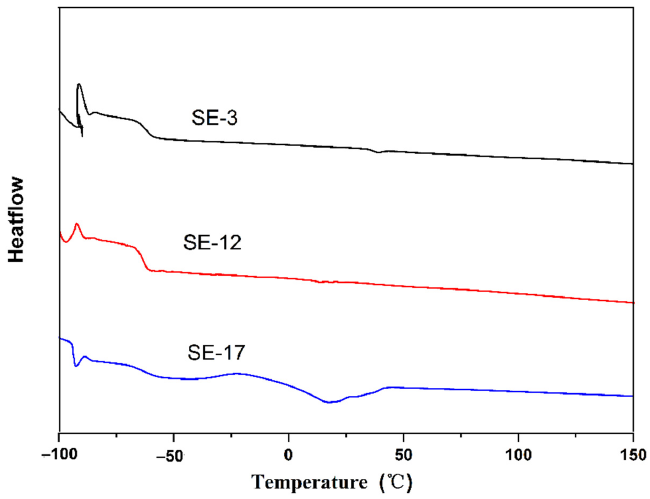
Figure 5. The DSC curves of SE-3, SE-12, and